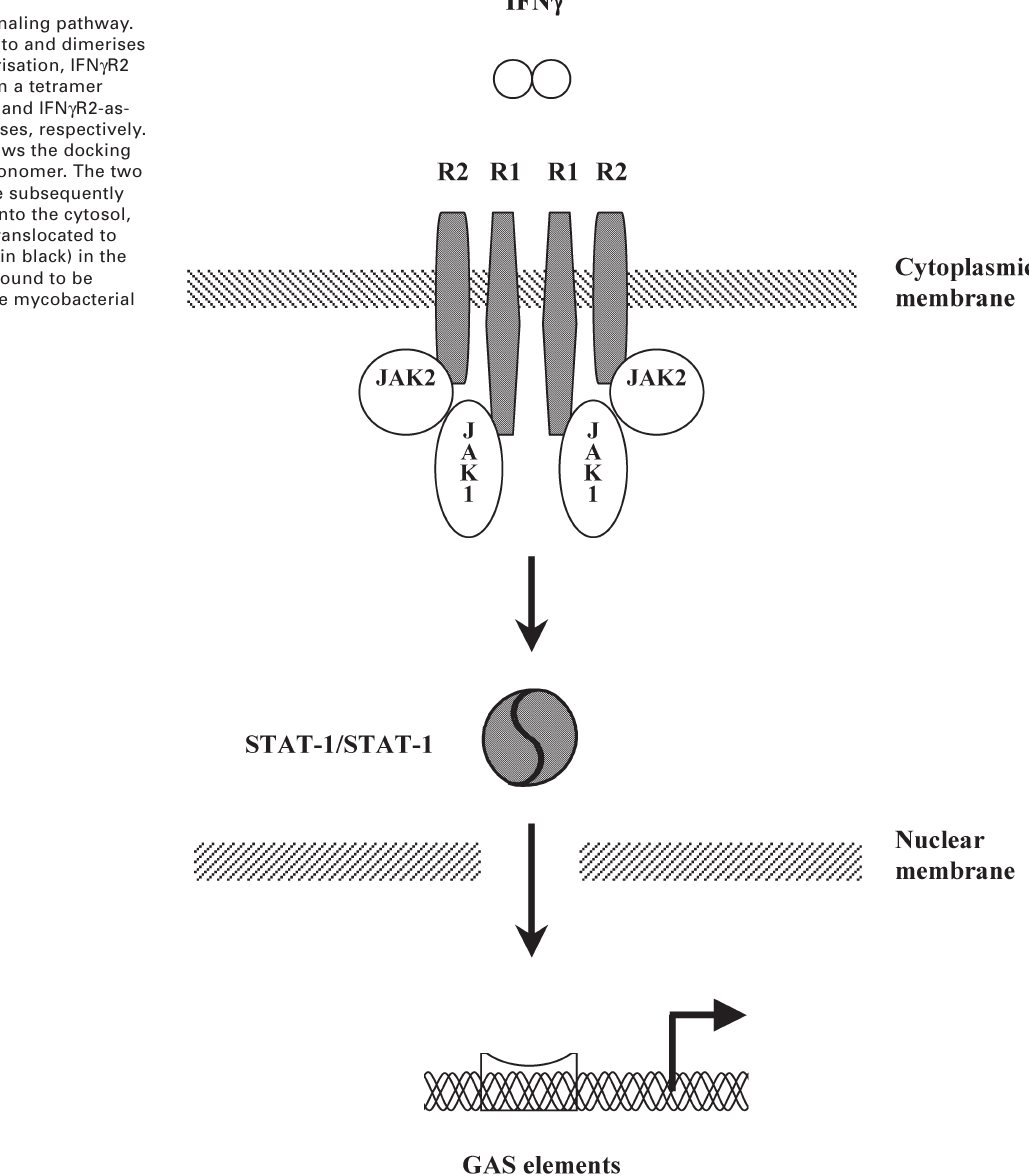
Figure 2 Genetic defects in the IFN γ -signaling pathway. IFN γ is a homodimer that bind to and dimerises IFN γ R1 molecules. Upon dimerisation, IFN γ R2 molecules are recruited to form a tetramer which brings together IFN γ R1- and IFN γ R2-as- sociated JAK-1 and JAK-2 kinases, respectively. Phosphorylation of IFN γ R1 allows the docking of STAT-1, a latent cytosolic monomer. The two STAT-1 molecules recruited are subsequently phosphorylated and released into the cytosol, where they dimerise and are translocated to the nucleus. Three molecules (in black) in the signaling pathway have been found to be mutated in patients with severe mycobacterial